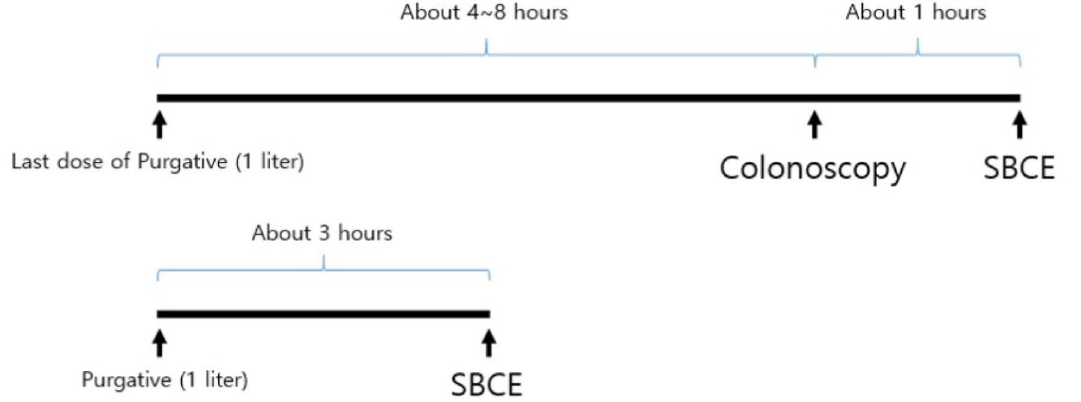
Figure 4. Schematic of the study process. (A) In the case of performing a small bowel capsule endoscopy (SBCE) immediately after colonoscopy, bowel preparation was performed by the split-dose or same-day regimen using 2 L of polyethylen glycol (PEG) + ascorbic acid. After colonoscopy, SBCE was performed about an hour later if necessary. (B) The bowel preparation for SBCE was performed by same-day and low dose preparation. Patients undergoing SBCE were instructed to start taking the 1 L of purgative 3 h before the SBCE, and finish taking it 1 h before the